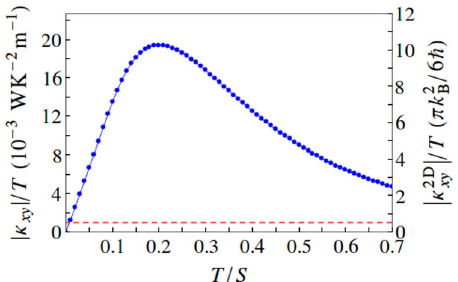
Fig. 5 Thermal Hall effect. The thermal Hall conductivity (in absolute value) due to magnons in the vortex liquid at φ ¼ tan (cid:2) 1 ð 1 = 2 Þ and h / S = 1.3, as a function of temperature (joined blue dots). The half-quantized thermal hall conductance κ 2D ð 1 = 2 Þð π = 6 Þð k 2 B = _ Þ is also indicated (red dashed line) for